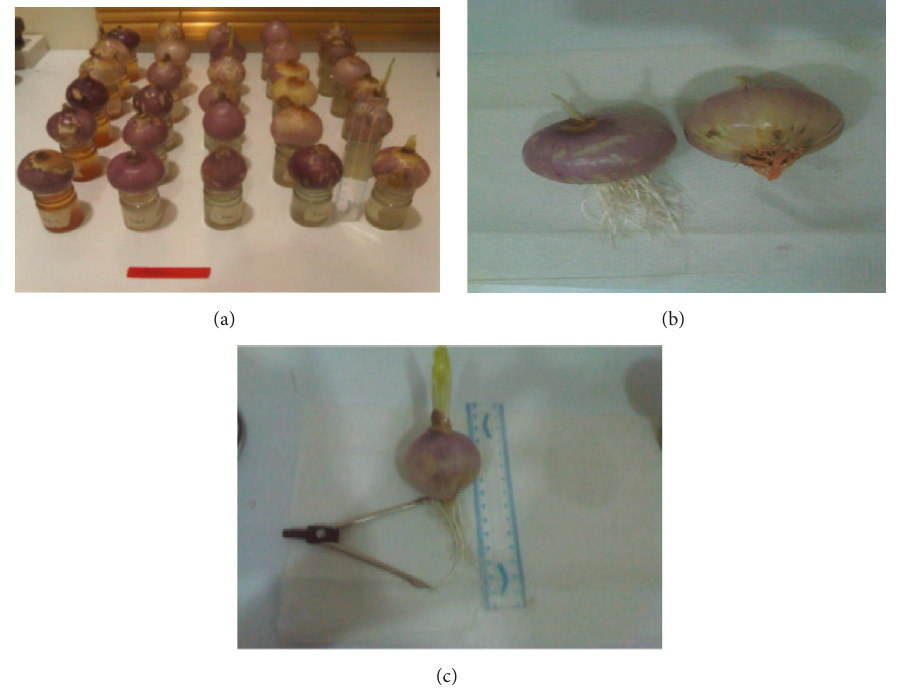
Figure 1: (a) Assay set-up showing onion root tips treated with different concentrations of DHAP. (b) Picture showing onion bulbs with normal (left) and inhibited (right) root growth after being treated with DHAP. (c) Picture showing how onion root tips were measured with the aid of a ruler and